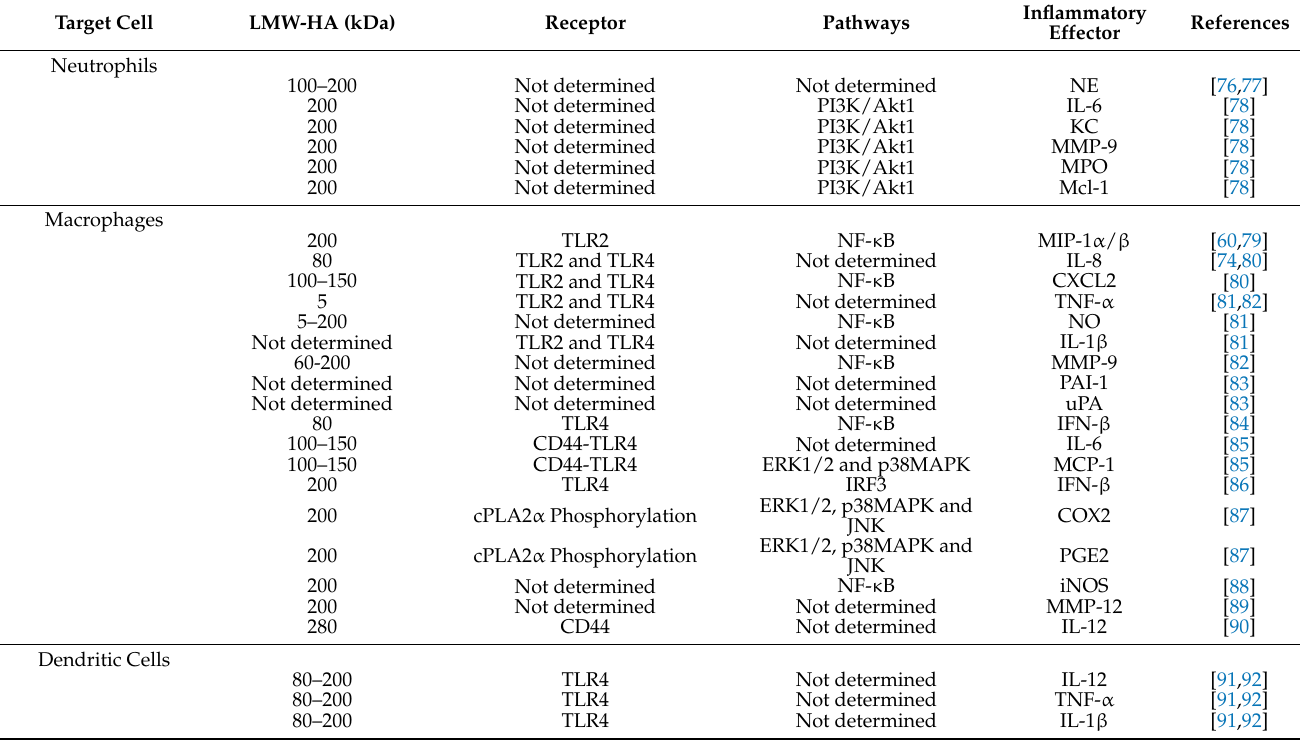
Table 1. LMW-HAs influence inflammatory marker